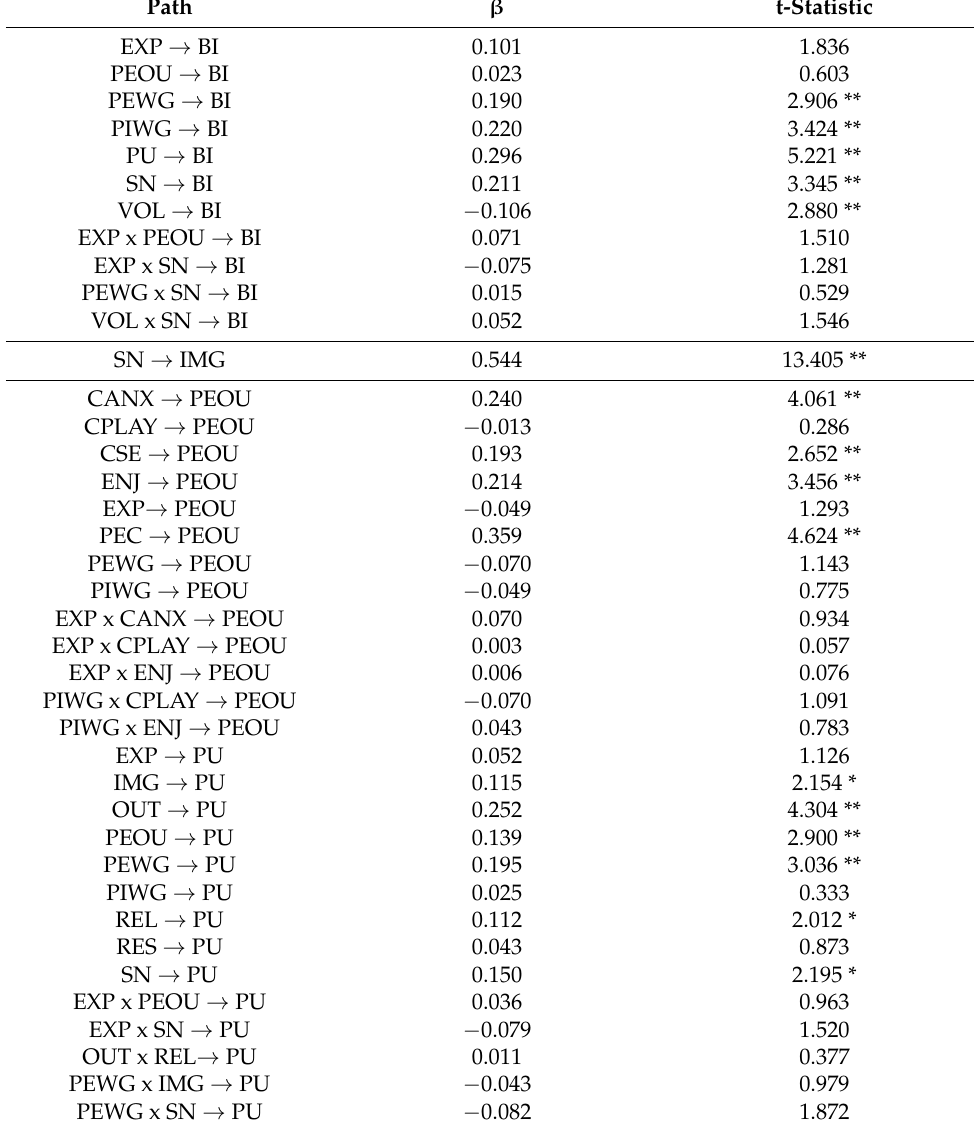
Table 4. Structural Model